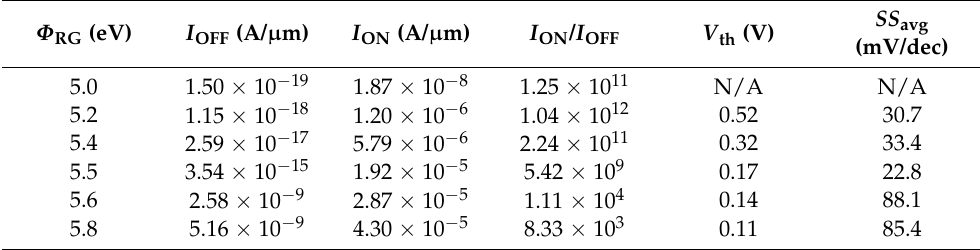
Figure 8. ( a ) Energy band profiles along A –A’ and B–B’ in the OFF -state; ( b ) energy band profiles along C –C’ in the OFF -state; ( c ) energy band profiles along A –A’ and B–B’ in the ON -state; and ( d ) energy band profiles along C –C’ in the ON -state, for DGNP-EHBTFET with Φ RG = 5.0 ~ 5.8 eV. Table 2. Extracted parameters from transfer characteristic curves at Φ RG = 5.0~5.8 eV.